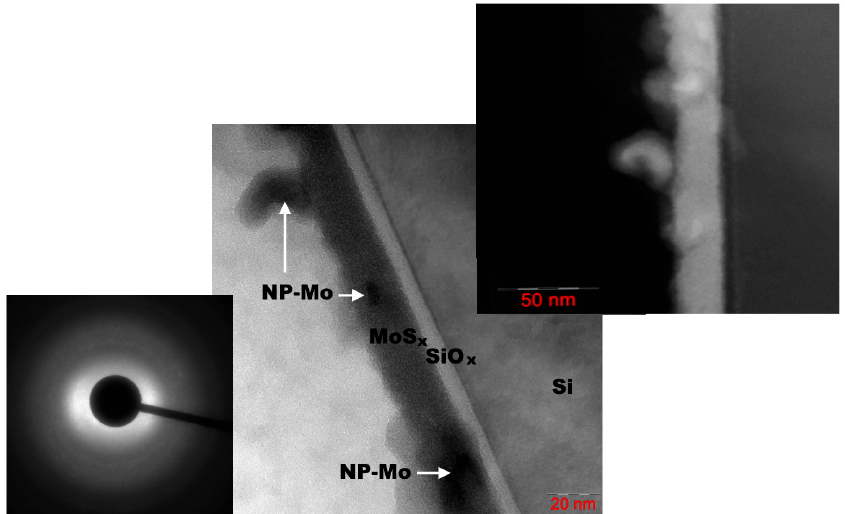
Figure 9. TEM image of a 20 nm thick a-MoS x /NP-Mo film prepared by PLD on n + p-Si. The inserts show the SEAD pattern (left) and the HAADF image (right) of the film.